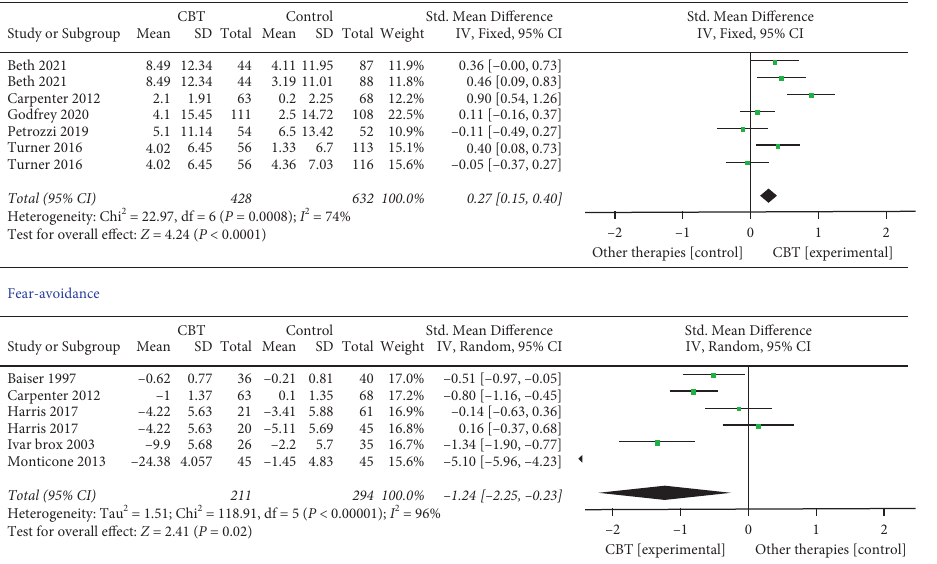
Figure 5: Self-efficacy and fear avoidance after intervention. The overall effect of CBTon self-efficacy and fear avoidance after intervention was in favor of other therapies ( P < 0 . 05).